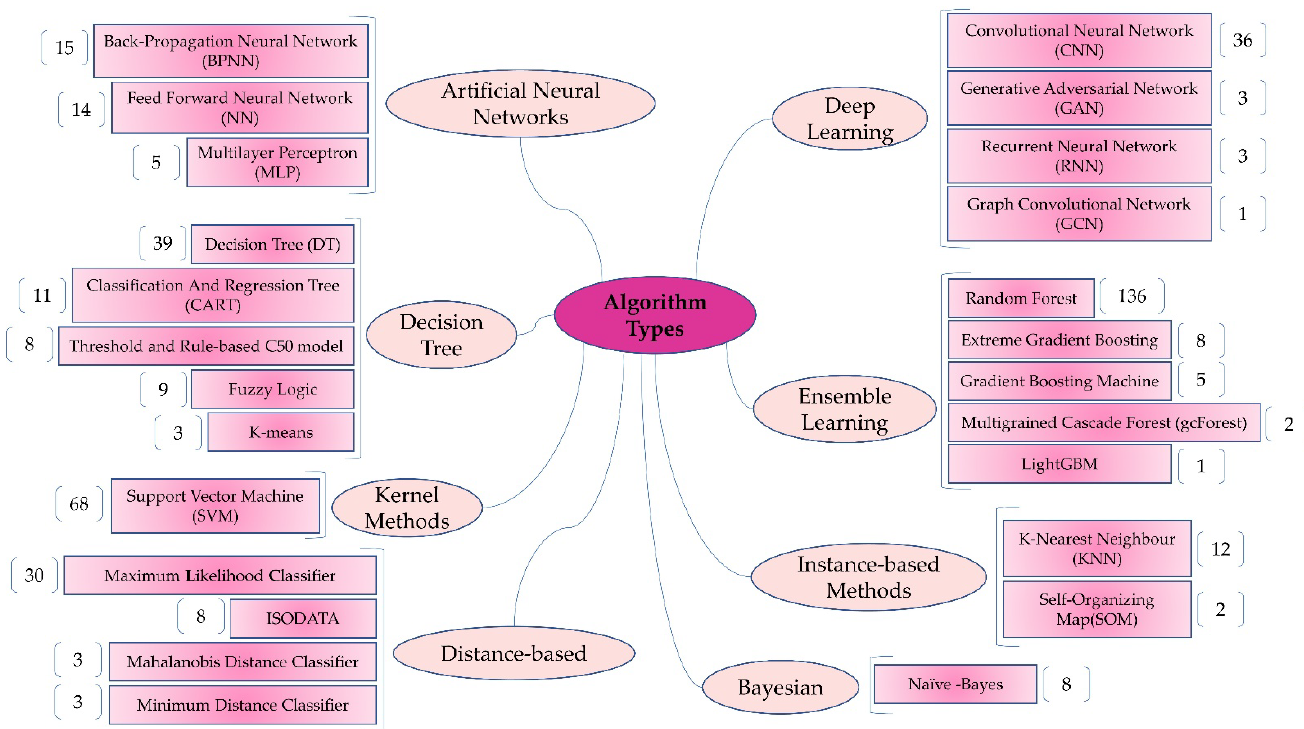
Figure 16. Number of studies employed different ML models in wetland